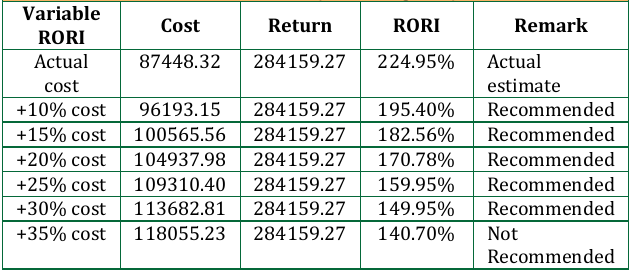
Table 9: Sensitivity analysis of Rate of Return on Investment of bio- fortified cassava (Increasing Cost)